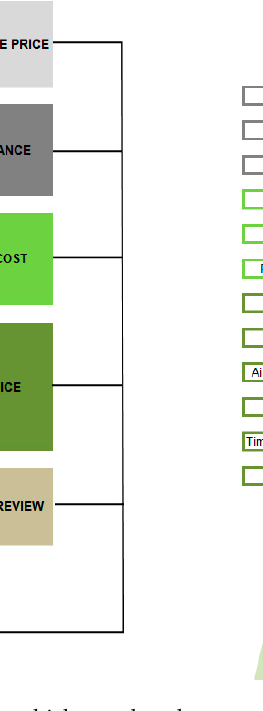
Figure 13. TCO model for the vehicles analysed.